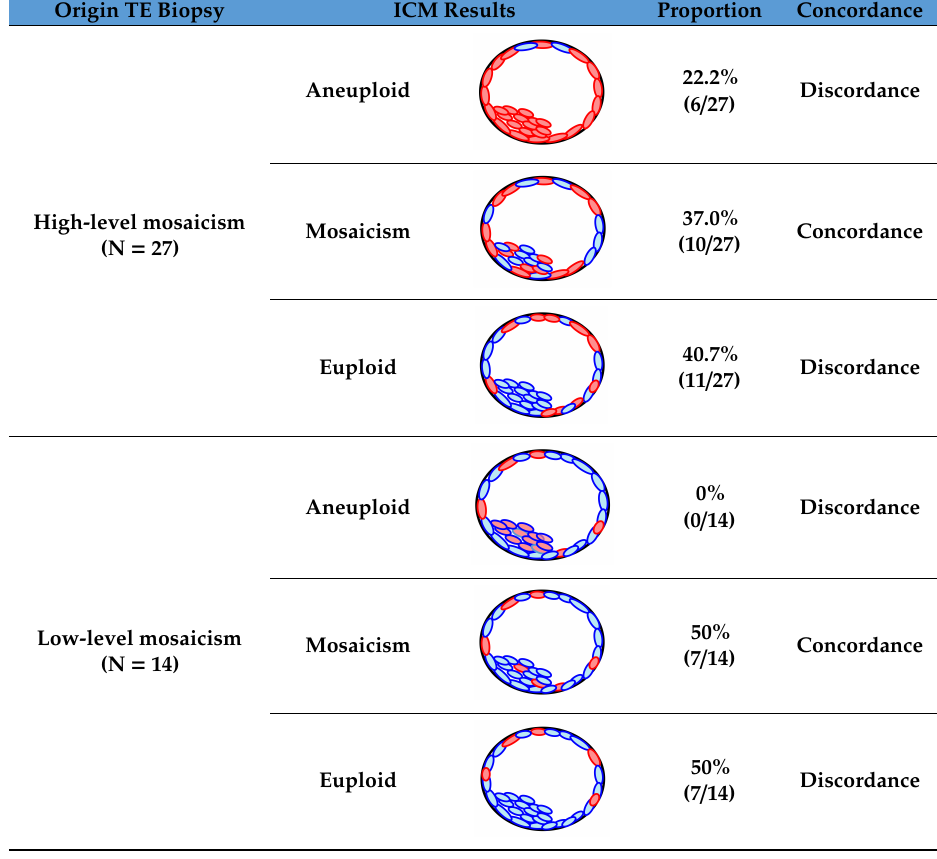
Table 3. Concordance between original trophectoderm (TE) biopsy and inner cell mass (ICM). Origin TE